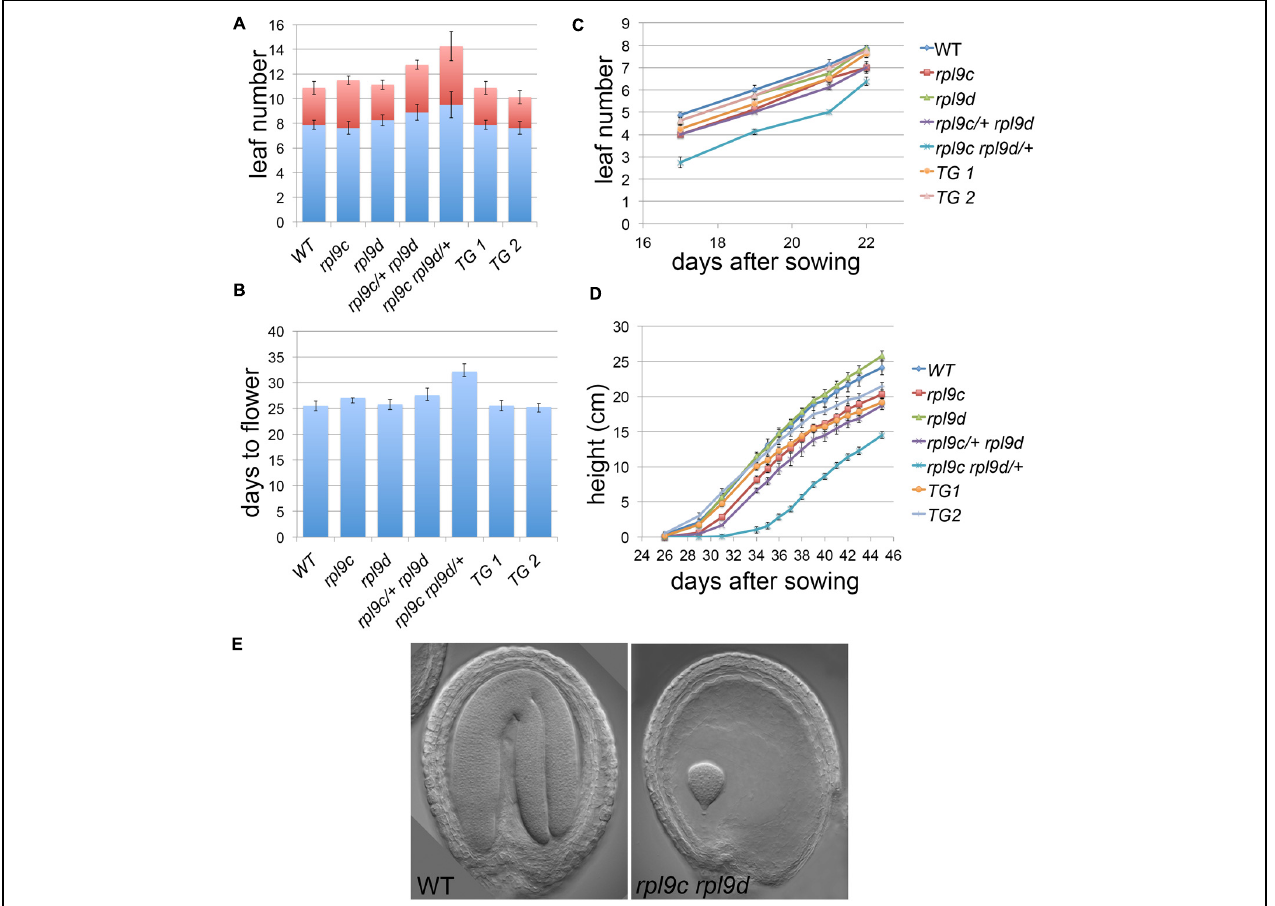
FIGURE 2 | Mutations in RPL9 genes delay growth. The number of rosette (blue) and cauline (red) leaves (A) , days to flower (B) , rate of rosette leaf emergence (C) , and rate of inflorescence growth (D) are shown for the genotypes wild type, rpl9c , rpl9d, rpl9c/ + rpl9d, rpl9c rpl9d/ + , and for two independent lines rpl9c homozygous for the transgene RPL9D:RPL9D (TG1 and TG2). Data is the mean ± SE ( n = 8). Embryos from a silique of an rpl9c/ + rpl9d plant (E) . A mature wild type embryo (left) and a putative homozygous rpl9c rpl9d embryo arrested at a late globular stage of development (right).